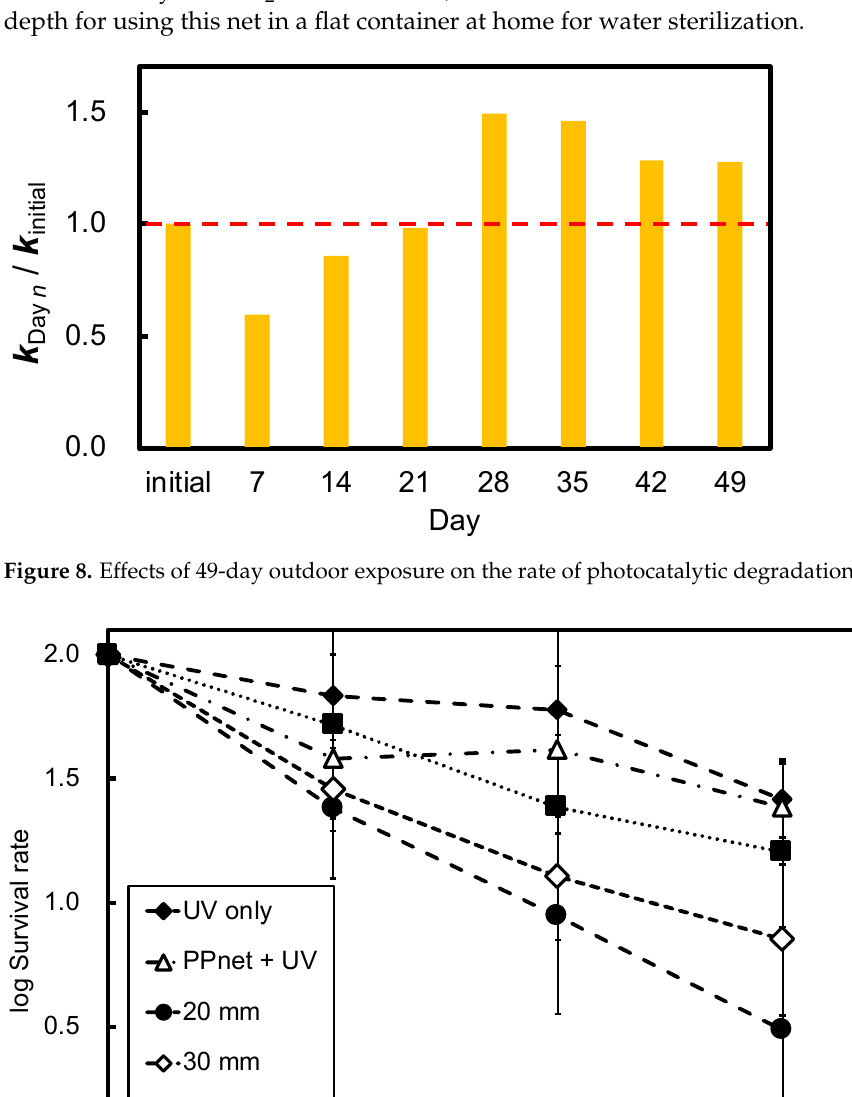
Figure 7. SEM images of the HDTMS-TiO 2 net left outside for 1, 28, and 49 days.